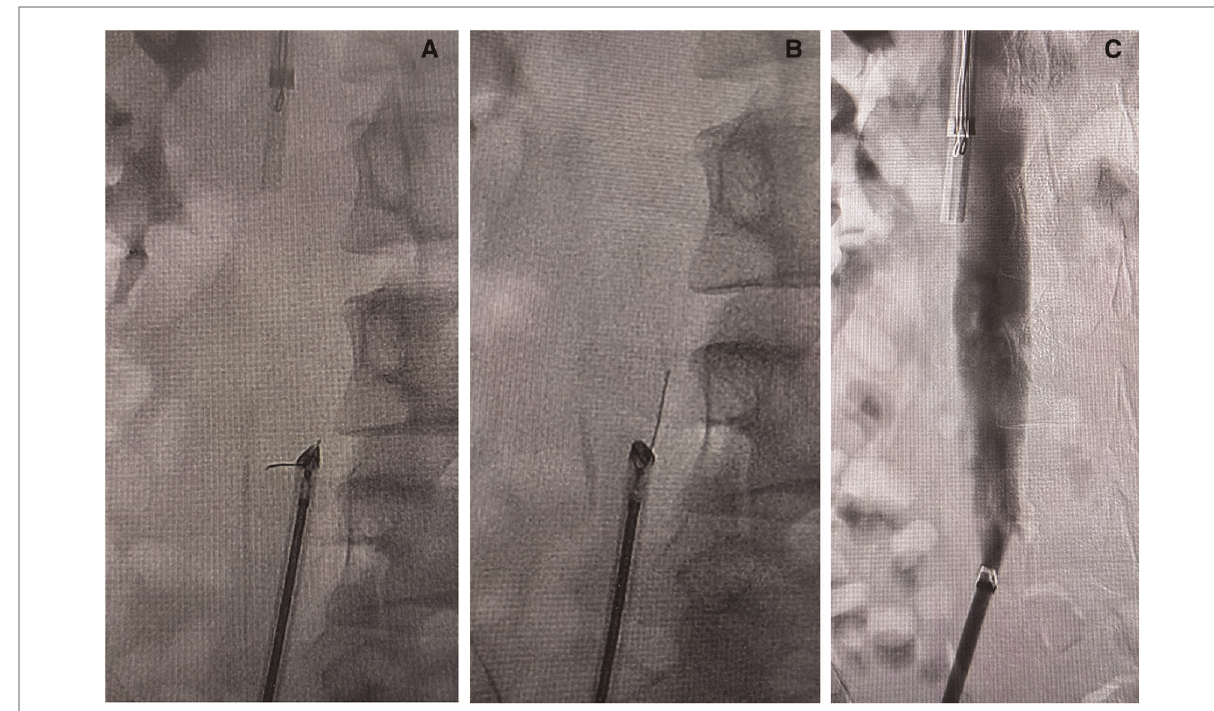
FIGURE 3 ( A ) The fractured pedicle at a vertical angle to the retrieval sheath and failure of removal. ( B ) The biopsy forceps and the retrieval sheath were pulled toward the distal end to coaxial lines and the broken pedicle was successfully removed. ( C ) The inferior vena cava was unobstructed, without spillage of the contrast